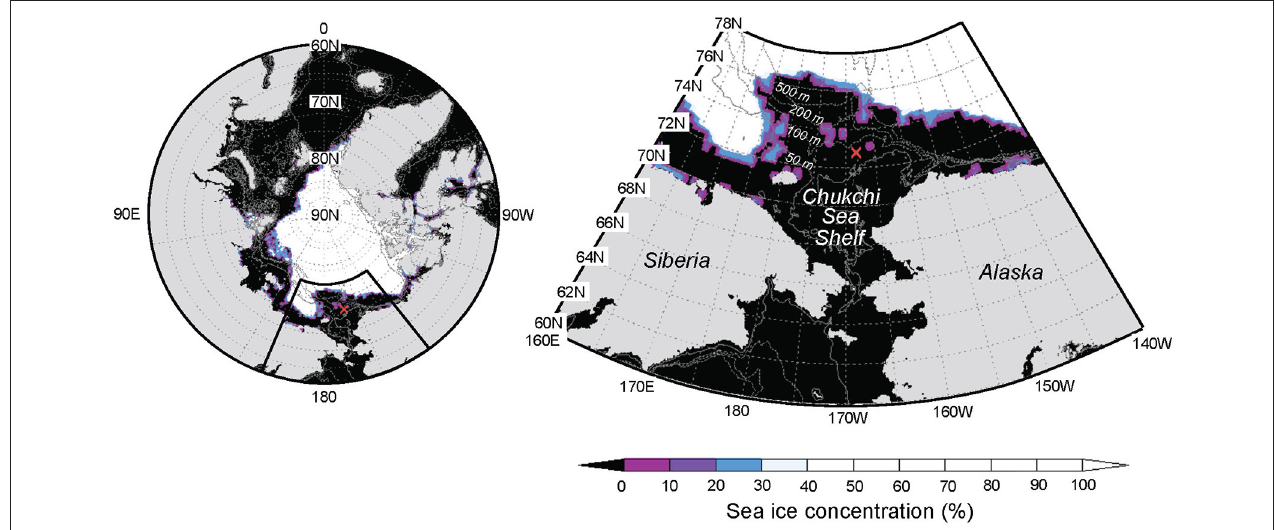
FIGURE 1 | Location of the fixed-point observation (FPO) station (red cross) on the Chukchi Sea Shelf, western Arctic Ocean (Stn. 41; 72.75 ◦ N, 168.25 ◦ W; bottom depth, 56m). Gray contours are isobaths (2-Min Gridded Global Relief Data; ETOPO2v2). Sea ice concentrations on 16 September 2013 are also shown (NCEP Climate Forecast System Version 2;